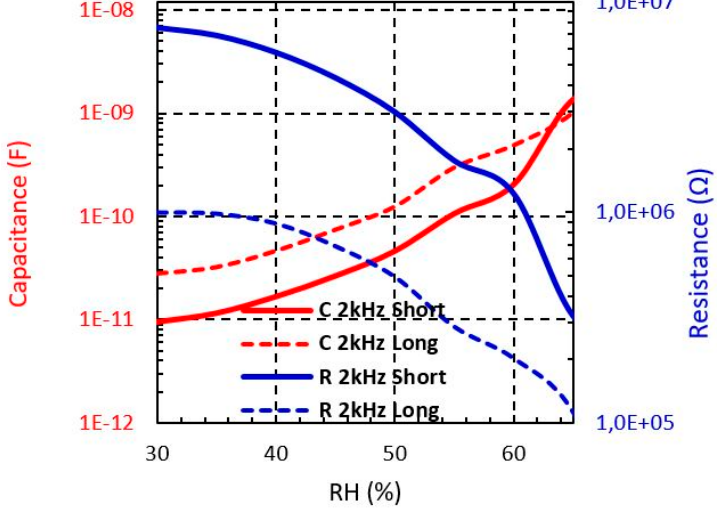
Figure 9. Measured Bekaert (PES-SS) sensors impedance from 30% to 65% RH at different frequencies .